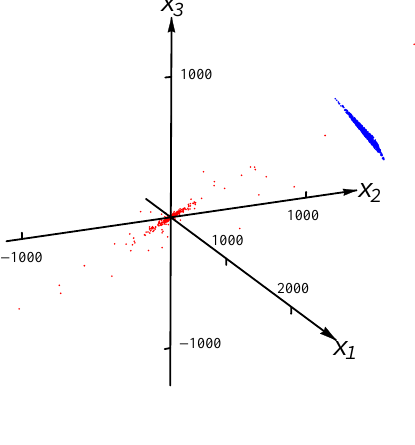
Figure 7. Sample from four Gaussian distributions with 10% artificial